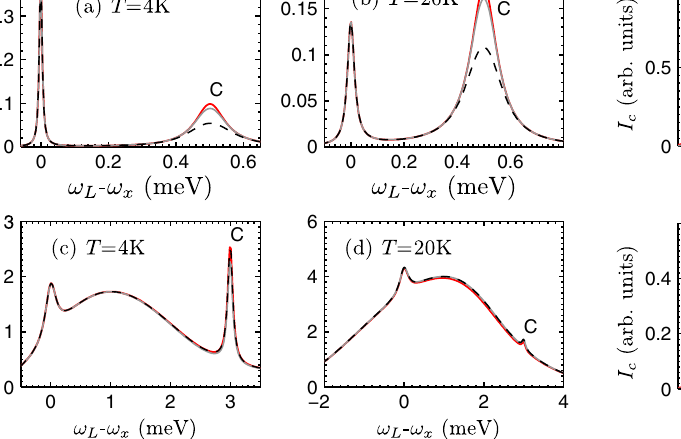
FIG. 10. (a)-(b) Relative cavity-mode intensity as a function of ¼ QD-laser detuning for a dot-driven system at two different cx temperatures, (a) T ¼ 4 K and (b) T ¼ 20 K , and for different ¼ 20 (cid:8) eV : black dashed values of the cw Rabi frequency ( (cid:4) x ¼ 40 (cid:8) eV : grey solid line, and (cid:4) ¼ 60 (cid:8) eV : red solid line, (cid:4) x x line). The cw field drives the QD which is detuned to the right of ¼ (cid:1) 3 meV ). Note that h B i ¼ the cavity mode by 3 meV ( (cid:1) cx 0 : 91 at T ¼ 4 K and h B i ¼ 0 : 73 at T ¼ 20 K . (c) Normalized cavity-mode intensity in the presence of only ZPL broadening with h B i ¼ 1 at T ¼ 4 K . (d) Plot of the x FWHM of the PL . The orange intensity at the QD resonance as a function of (cid:4) c crosses show the FWHM at T ¼ 20 K , the blue circles at T ¼ 4 K , and the red inverted triangles show the intensity FWHM with only ZPL broadening and h B i ¼ 1 (no